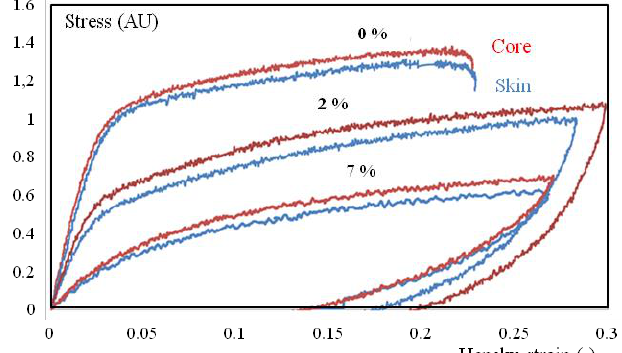
Figure 12. True stress-true strain cycles for tensile tests of core (red), and surface (blue) specimens with different water contents (in wt.% on the curves). The strain rate is 4 10 − 3 s − 1 and the temperature is 23 °C. Samples were extracted from the first third of the plaque (close to the gate).